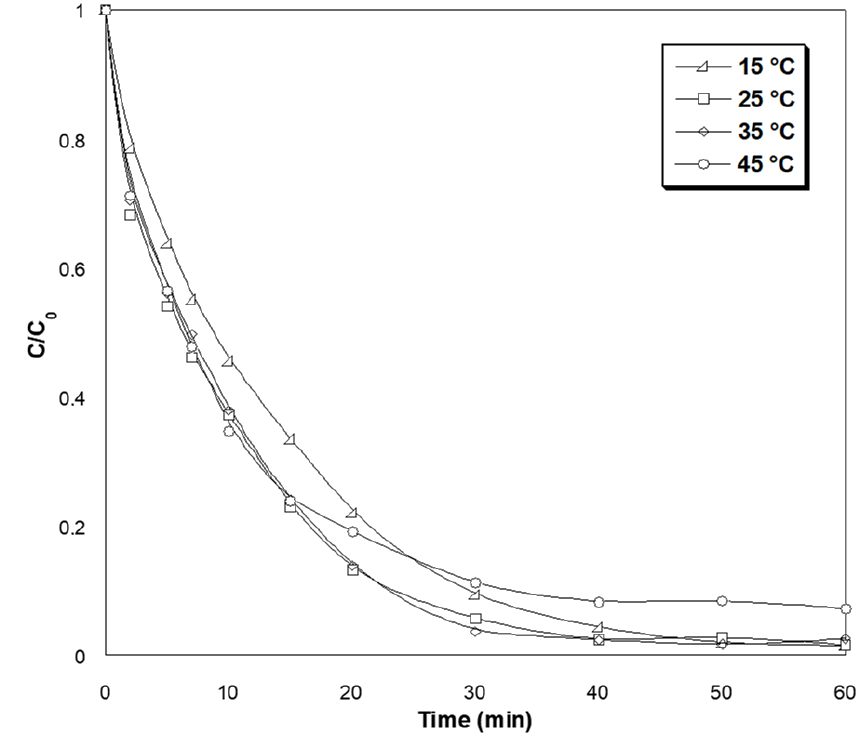
Figure 7. Effect of liquid temperature in the range of 15–45 °C on the degradation of SO by UV/TiO 2 /IO 3 − process ([IO 3 − ] = 0.15 mM, [TiO 2 ] = 0.4 g · L − 1 , [SO] = 10 mg · L − 1 and pH~6). The process seemed to be less sensitive to the temperature variation in the